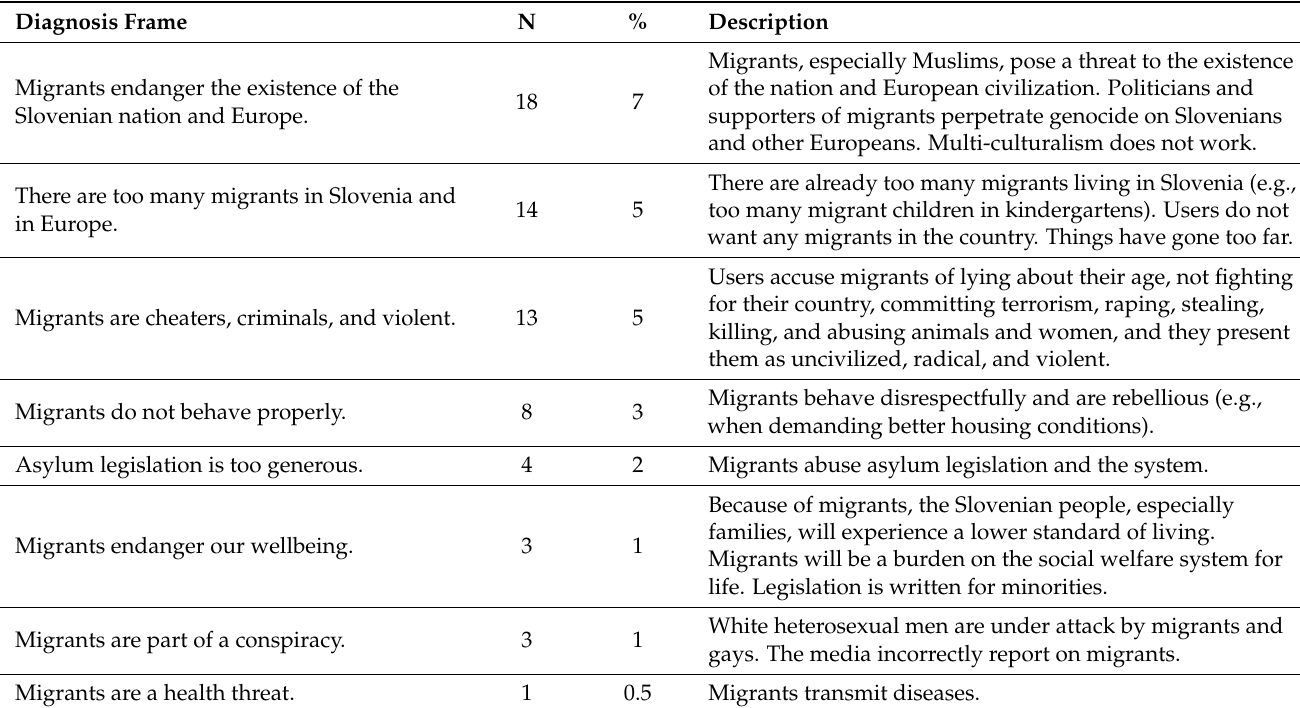
Table 3. Diagnosis: frames, numbers, shares, and frame descriptions of the statements (N =